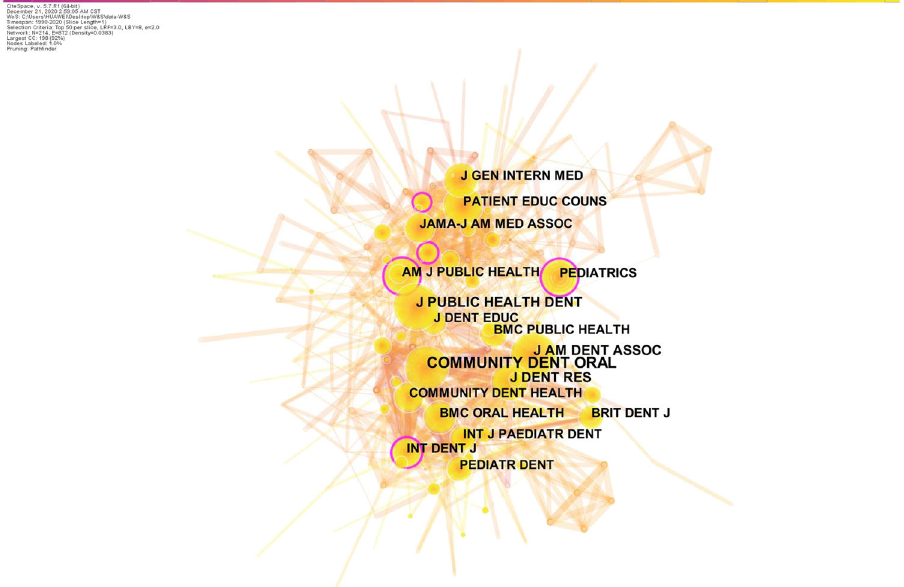
Fig. 5 The distribution of cited journals. The network map of co-cited journals related to oral health literacy research.